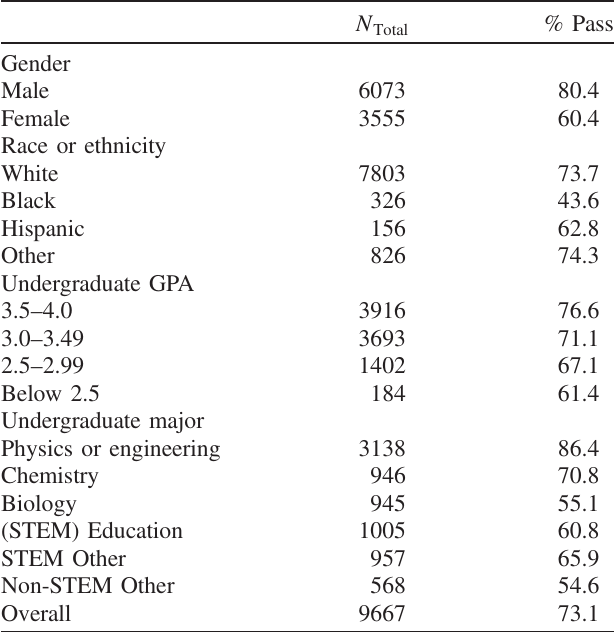
TABLE II. Personal and professional characteristics of Praxis physics subject assessment examinees from 2006 to 2016.